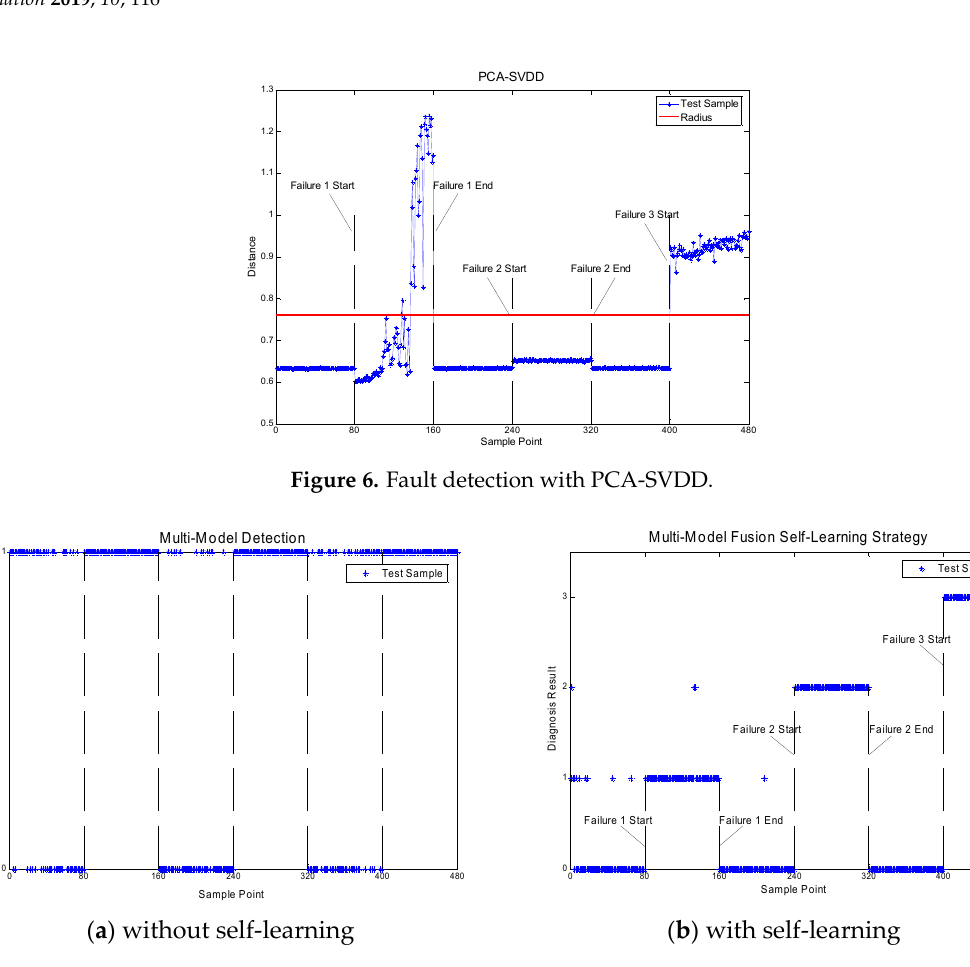
Figure 7. Fault detection results with multi-model.